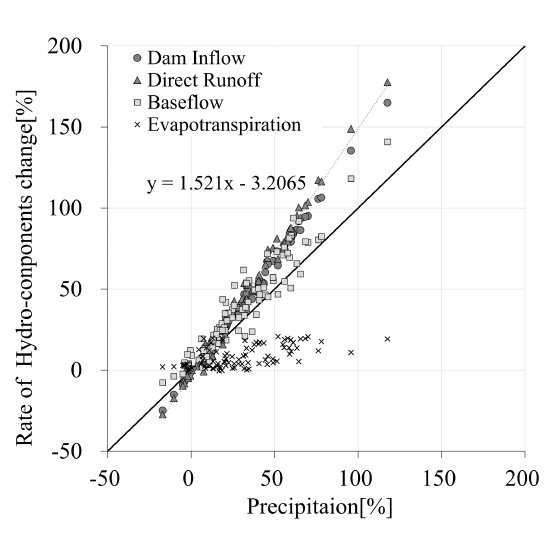
Figure 11. Increasing rates of hydrologic components with respect to